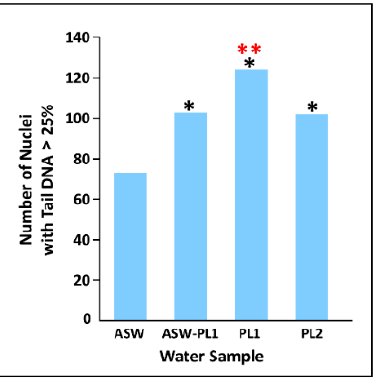
Figure 4. Genotoxicity tested on samples taken near the Palmachim infrastructure. A total of 300 uclei were analyzed per site/treatment. Significant differences: *—significant difference between field samples and modified control (ASW-PL1) relative to ASW control; **—significant difference between PL1 site vs. its salinity-matched control (ASW-PL1) and the other field